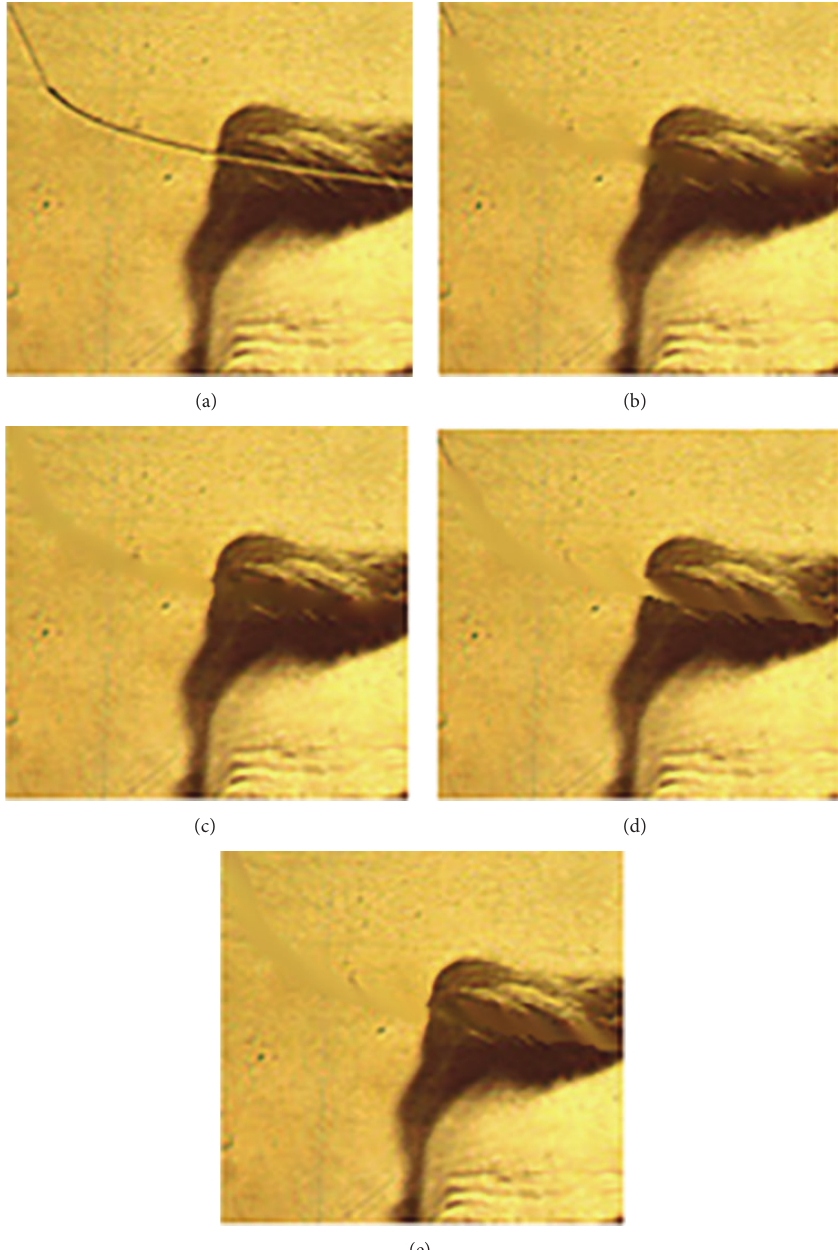
Figure 10: (a) Original image; (b) result for Oliveira’s method; (c) result for our adaptation of Oliveira’s method; (d) result for Hadhoud’s method; (e) result for our adaptation of Hadhoud’s